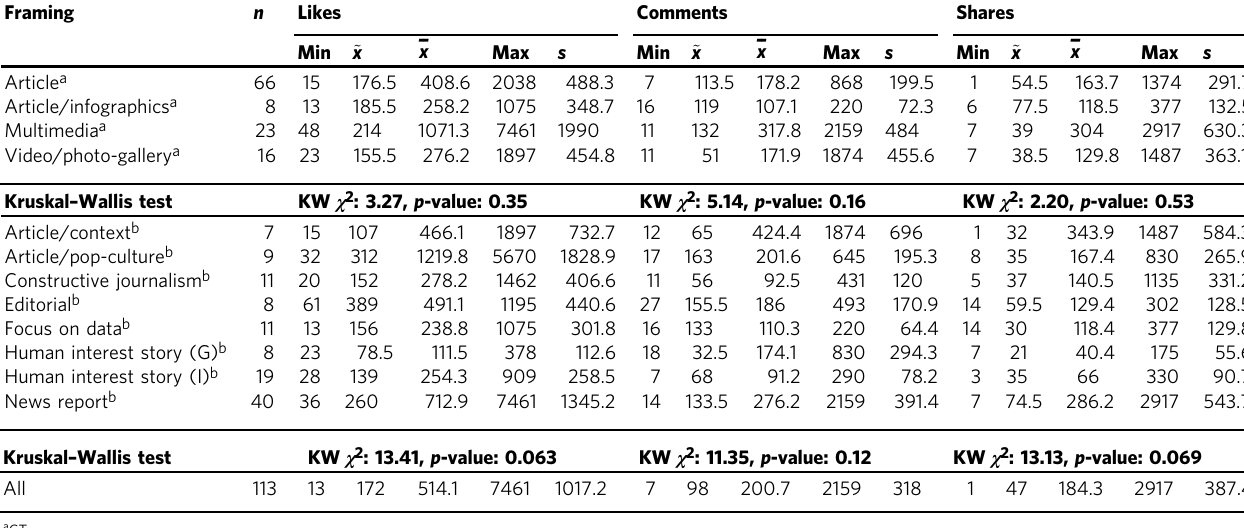
Table 2 Summary of the engagement metrics of the posts by content type (above) and by journalistic technique (below). Framing